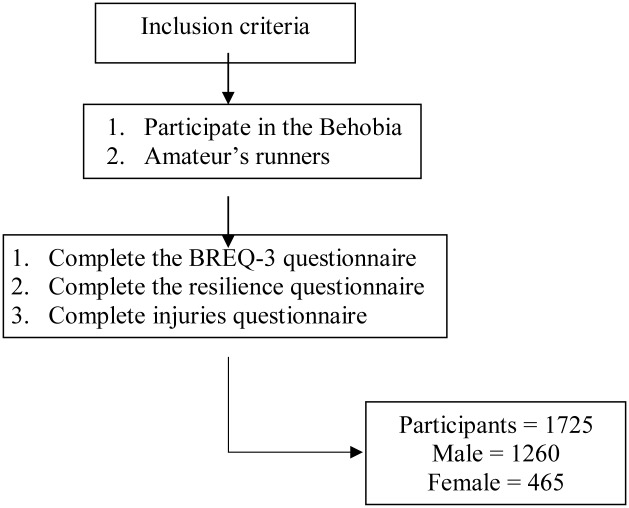
Flow chart of participants according to inclusion criteria.